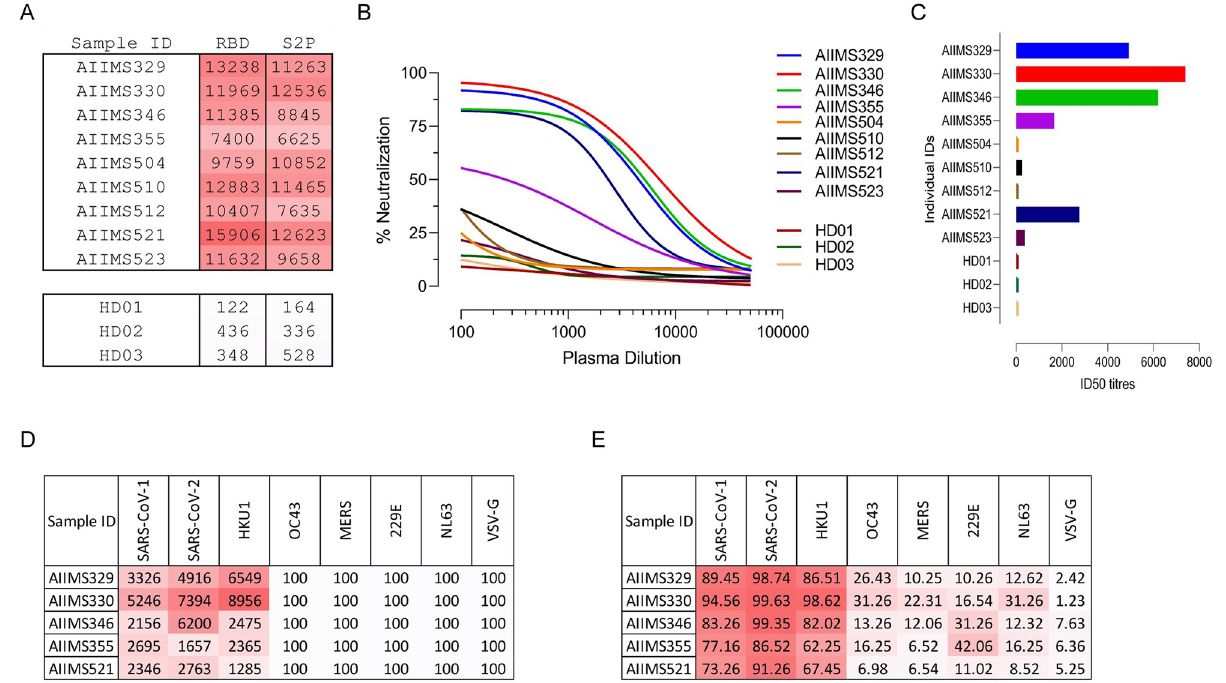
Fig 6. Polyclonal plasma of HIV-1 infected children neutralizes SARS-CoV-2. (A) Cross-reactivity of anti-HIV-1 neutralizing plasma antibodies from ten children with chronic HIV-1 infection against SARS-CoV-2 RBD and SARS-CoV-2 S2P ecto was assessed by ELISA. Plasma antibodies from three seronegative healthy donors were used as negative control. Area under the curve (AUC) of OD 450 values of a 12-point binding curve (range, inverse plasma dilution of 100 to 51200), from three independent experiments are shown. (B) Plasma samples were tested for their neutralization of pseudotyped SARS-CoV-2 virions. Percent neutralization was calculated by assessing relative luminescence units (RLU) in cell lysates of HEK293T-ACE2 cells 48 hours after infection with SARS-CoV-2 pseudoviruses in the presence of increasing dilution of plasma samples (range, inverse plasma dilution of 100 to 51200). (C) Respective ID 50 (50% inhibitory dilution) for plasma from all ten children are shown. (D) ID50 titres against lentiviral pseudoviruses of all seven coronaviruses from all five children that cross-neutralized SARS-CoV-2 (range, inverse plasma dilution of 100 to 51200). (E) Maximum percent neutralization of all seven pseudotyped coronaviruses at the fixed plasma dilution of 1:100.